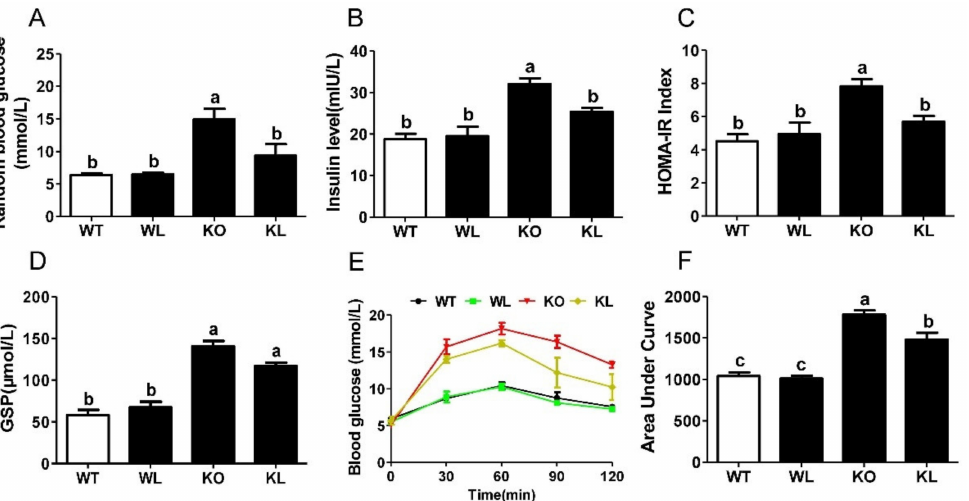
Figure 3. LWE decreased blood glucose and improved glucose tolerance in Lepr − / − rats. ( A ) Random blood glucose, ( B ) fasting serum insulin, ( C ) HOMA-IR, ( D ) glycated serum protein level was measured; ( E ) oral glucose tolerance test; ( F ) area under the curve of OGTT. Values are means ± SEM (n = 4–6). Columns with different letters are significantly different ( p <